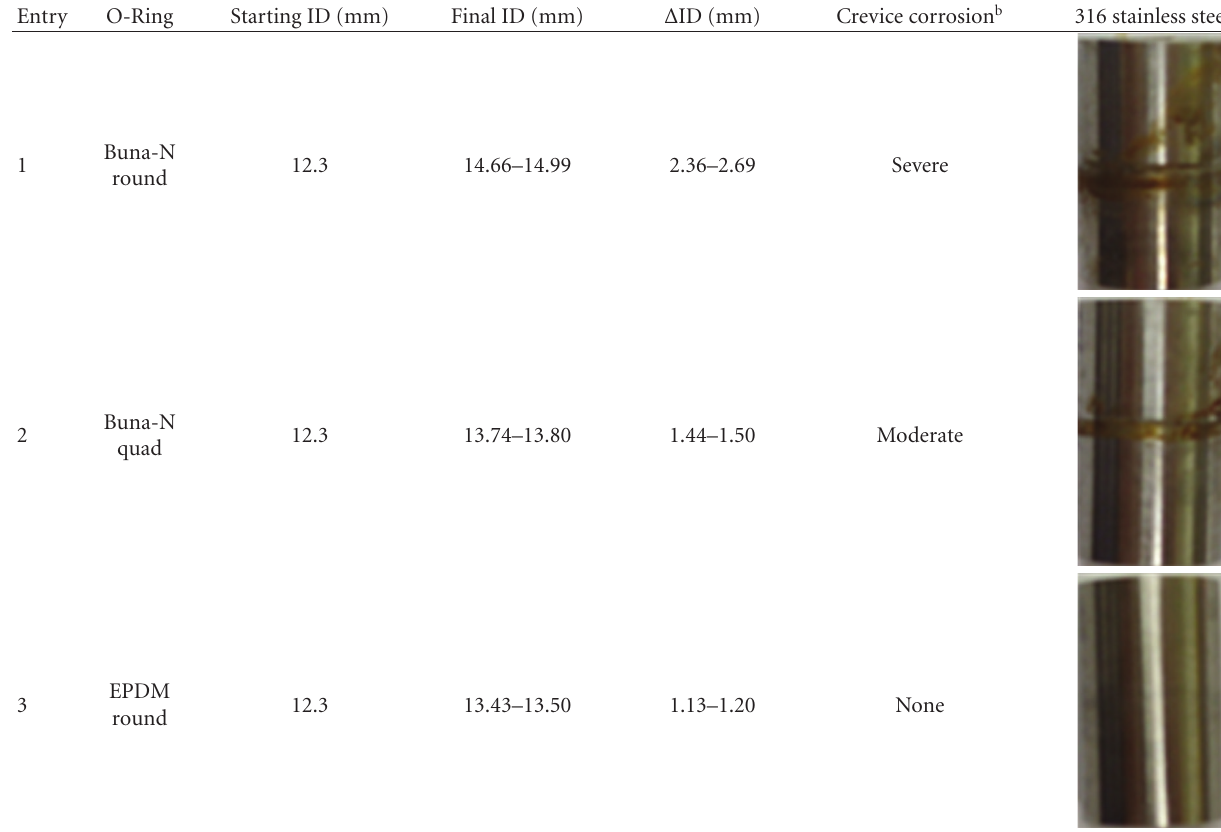
Table 2: Deformation of Buna-N and EPDM O-rings fitted on 316 stainless steel. a